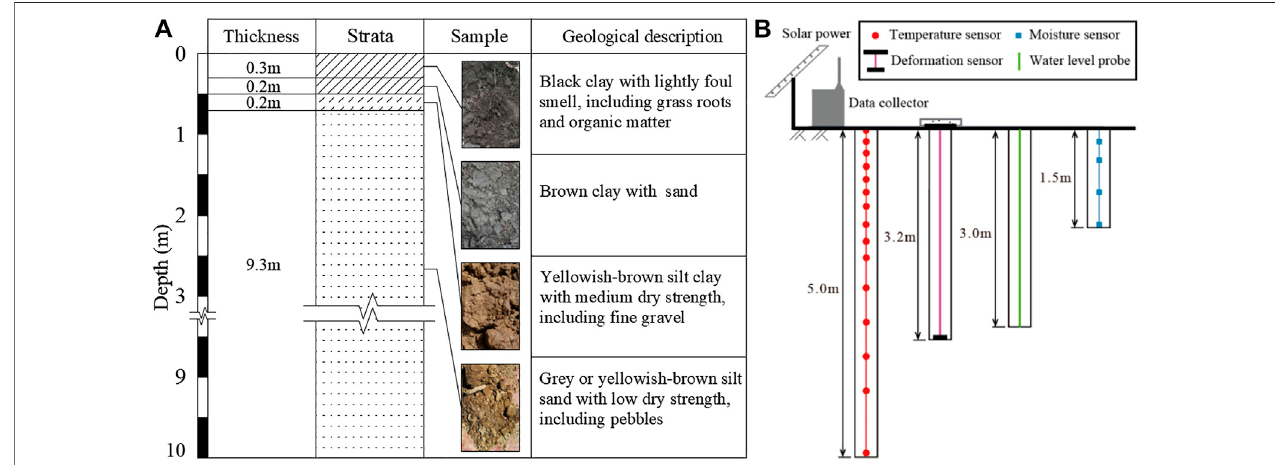
FIGURE 2 | Geotechnical condition and fi eld-monitoring system at the study sites. (A) Geotechnical condition; (B) schematic diagram of monitoring system.